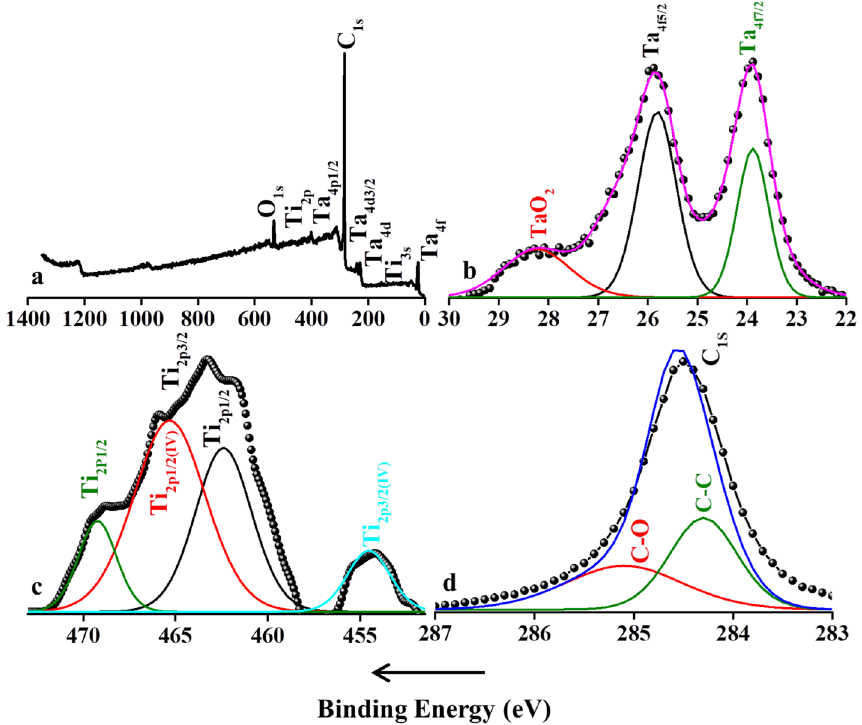
Figure 4. Full scan survey and deconvoluted XPS spectra of the synthesized bi-metal Ti x Ta (4−x) C 3 ( a ) full scan survey of the synthesized MXene ( b ) deconvoluted spectrum of Ti, ( c ) deconvoluted spectrum of Ta, ( d ) deconvoluted spectrum of